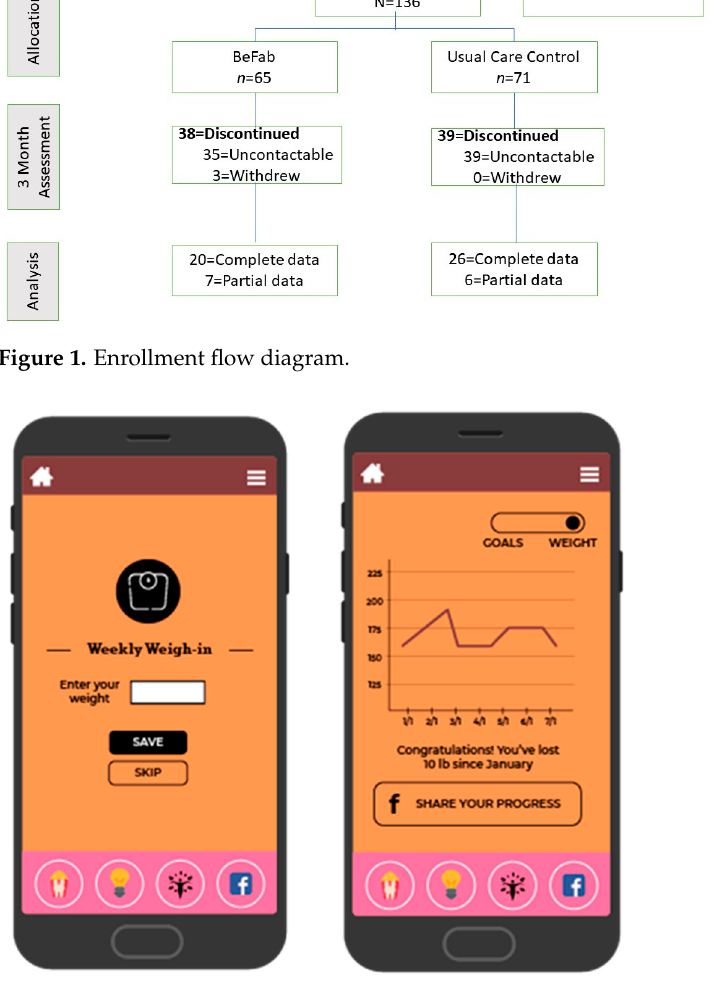
Figure 3. Screenshot of goal setting.